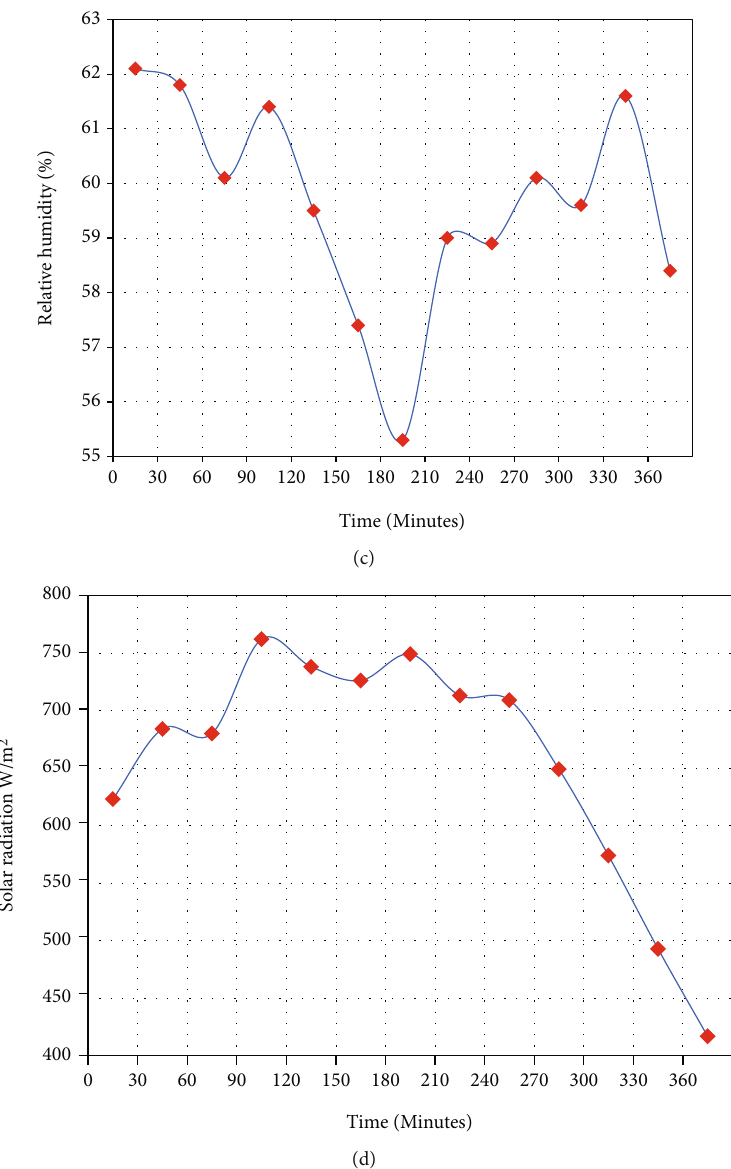
Figure 2: Variation of relative humidity and solar radiation (W/m 2 ) against time of the day in natural and forced